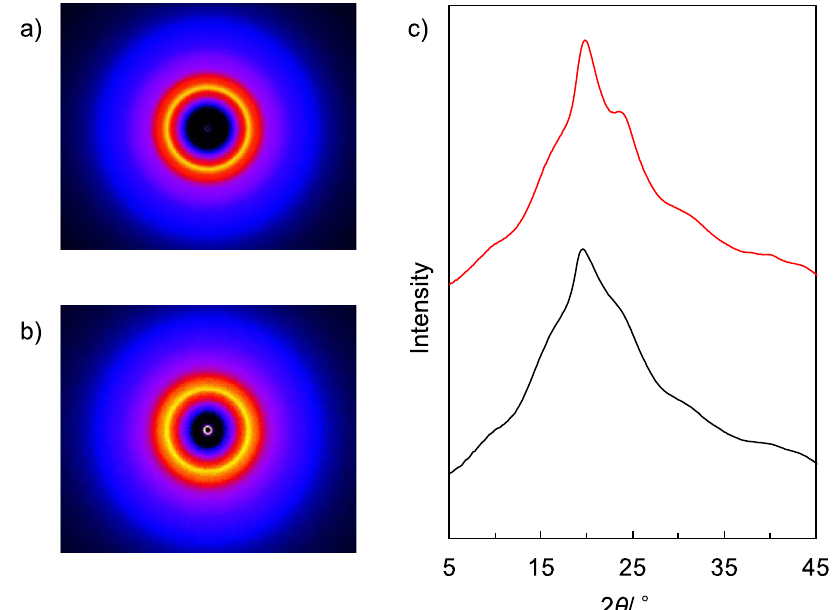
Bacteria strains Species Size of clear zone/mm NBRC 13287 Vibrio proteolyticus + NBRC 12875 Streptomyces griseus + NBRC 100445 Bacillus sp. ++ NBRC 100991 Pseudomonas sp. – NBRC 100993 Pseudoalteromonas haloplanktis Table 2. Clear zone formation ability on the BP1-containing media after 24 h. ++, large clear zone (> 4.0 mm) formed; +, medium clear zone formed (3.0–4.0 mm); –, no clear zone.